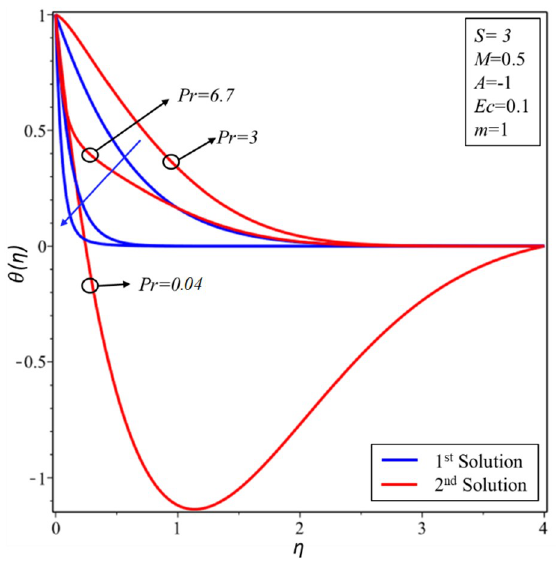
Figure 5. θ(η) for increasing values of Pr and α = 1.